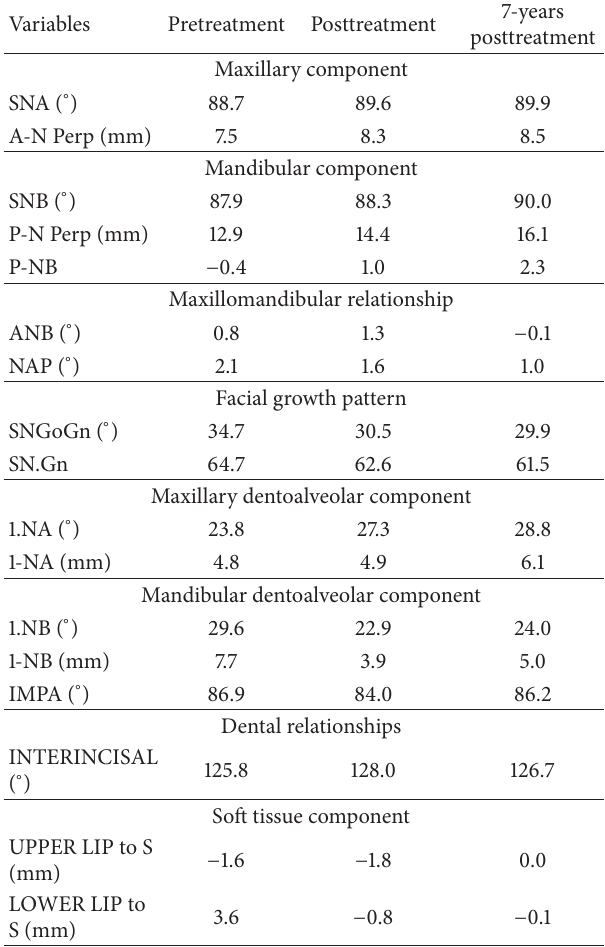
Table 1: Pretreatment and posttreatment cephalometric status